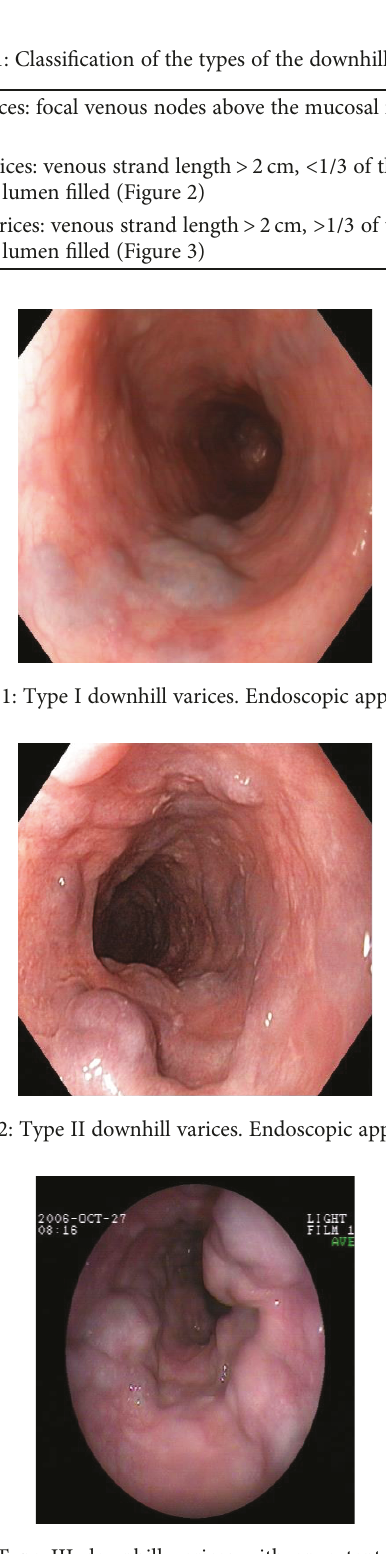
Figure 3: Type III downhill varices with an extent > 1/3 of the esophageal lumen. Endoscopic